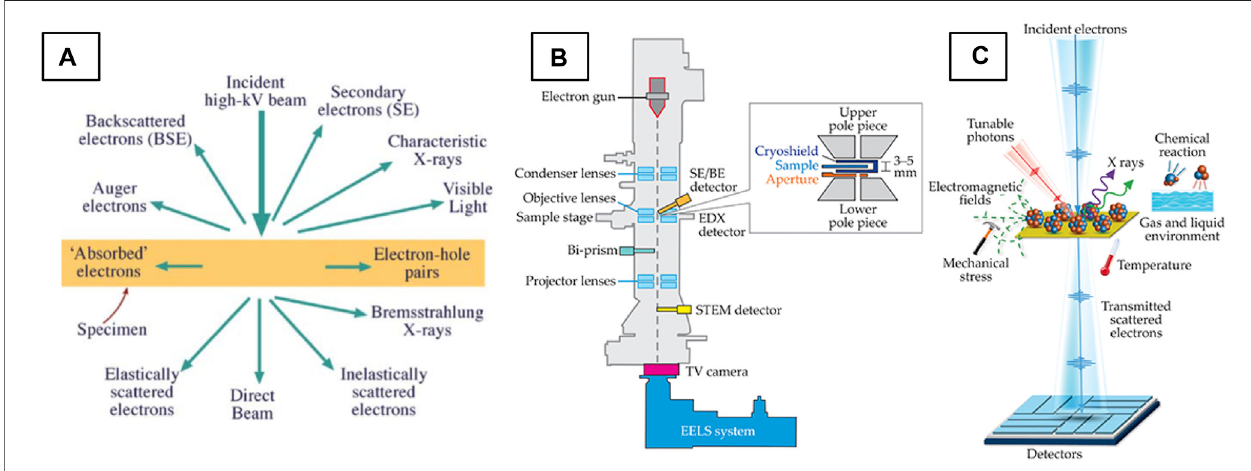
FIGURE 2 | Signals and detectors of the (S)TEM. (A) Schematic of signals produced through electron-matter interactions in the (S)TEM (Williams and Carter, 2009a) and (B) schematic of (S)TEM column hardware and detectors. (C) Schematic of in situ/operando capabilities (Zhu and Dürr, 2015).